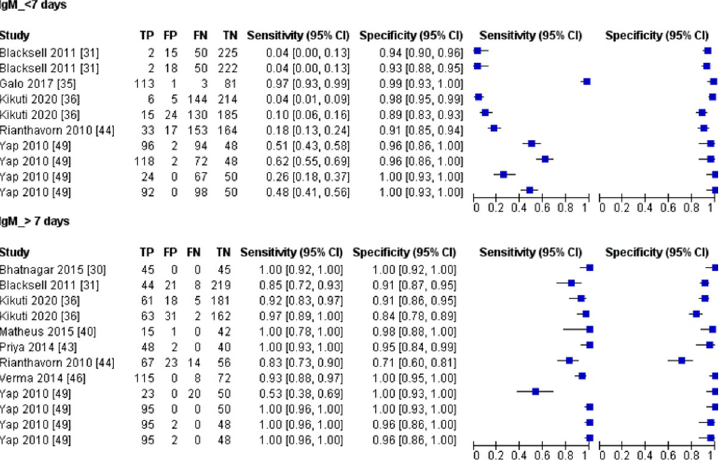
Fig 5. Forest plot for IgM detection test based on time of sampling; CI, confidence interval; TP, true positive; FP, false positive; FN, false negative; TN, true negative.